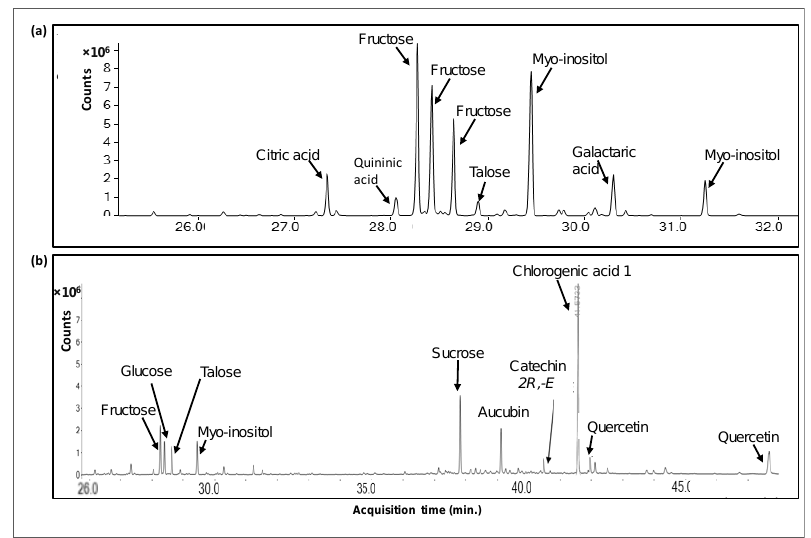
Figure 1. A GC/MS chromatogram of a metabolomic analysis of Pi infusion. The Pi infusion was run on an SPE Sep-Pak C18 cartridge and eluted with water to yield the aqueous phase ( a ), followed by methanol elution to yield the methanolic phase ( b ). Extracts were derivatized before analysis. Metabolites were analyzed by GC/MS metabolomics following C 18 SPE extraction with methanol (methanolic phase) and DDW (aqueous phase). Presented are metabo- lites that comprised at least 1% of the total ion count (total peak area) of the respective chromatograms. Quercetin and Quininic acid were identified by commercial